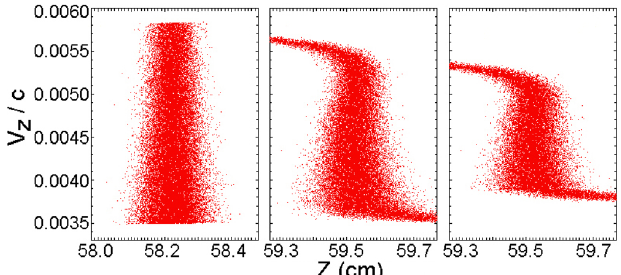
g phase space at the focal plane for the FIG. 11. (Color) f z; v z T k (cid:4) 0 : 2 eV beam using the sharp waveform across an infinitely thin gap (left), and smooth (center) and sharp (right) waveforms across the finite-size gap. Focus occurs at z (cid:4) (cid:8) 58 : 25 cm and t (cid:4) 950 ns for the former case, and at z (cid:4) (cid:8) 59 : 5 cm and t (cid:4) 959 ns for the latter